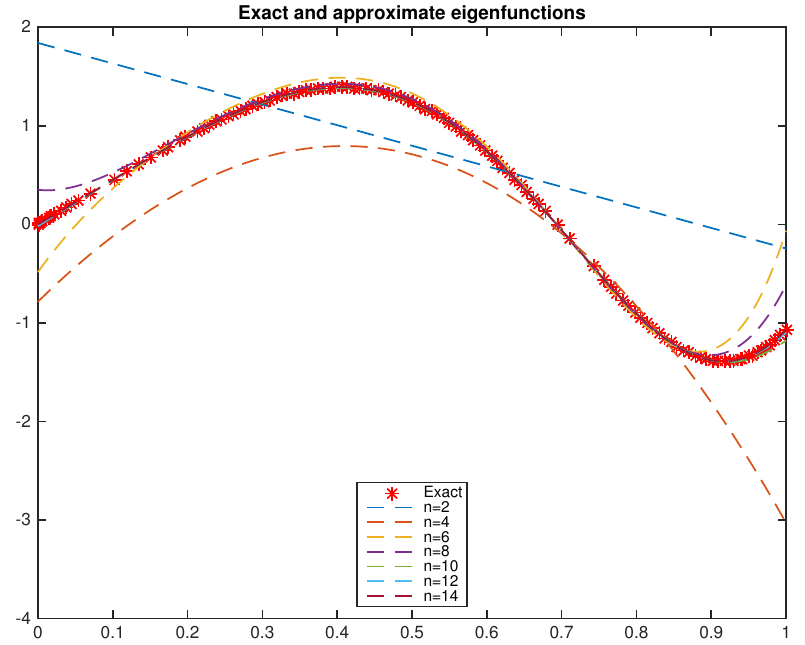
Figure 6. Exact and approximate eigenfunctions for the kernel K ( x , ξ ) = sin ( π exp ( x )) sin ( π exp ( ξ )) over [ 0,1 ] 2 at various truncation